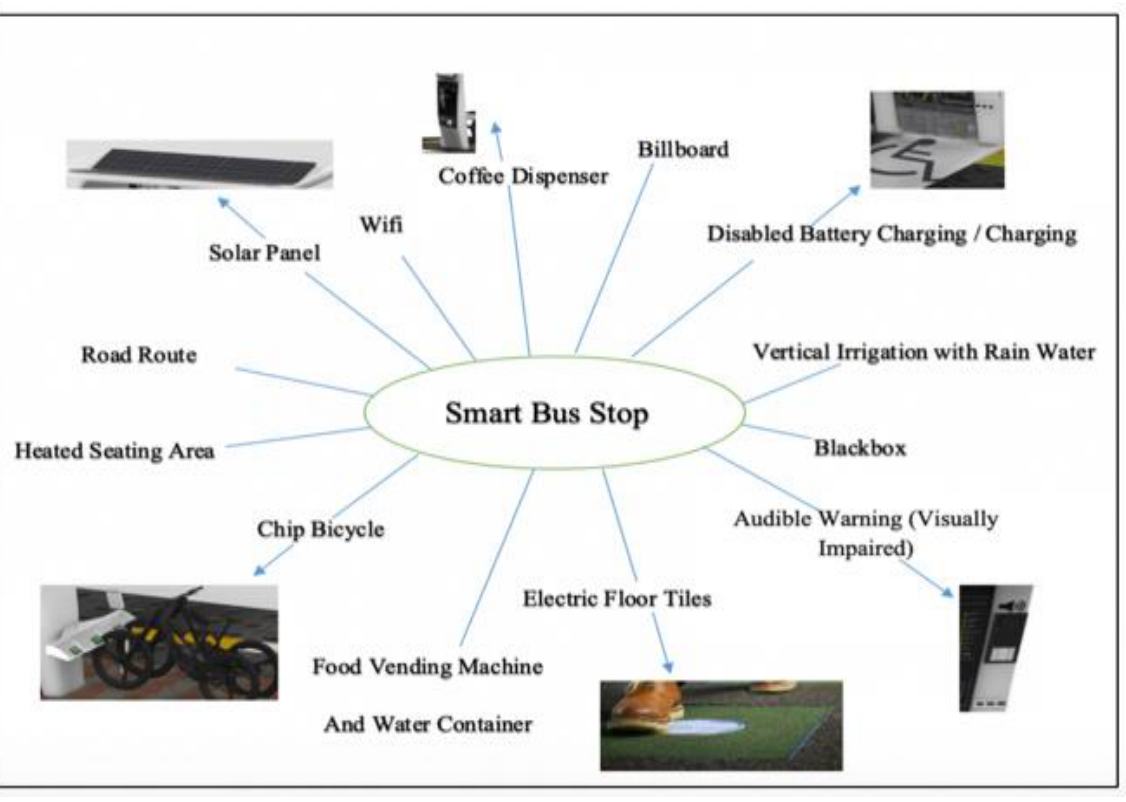
Figure 5. Smart Bus Stop Interaction Set Diagram in the Urban